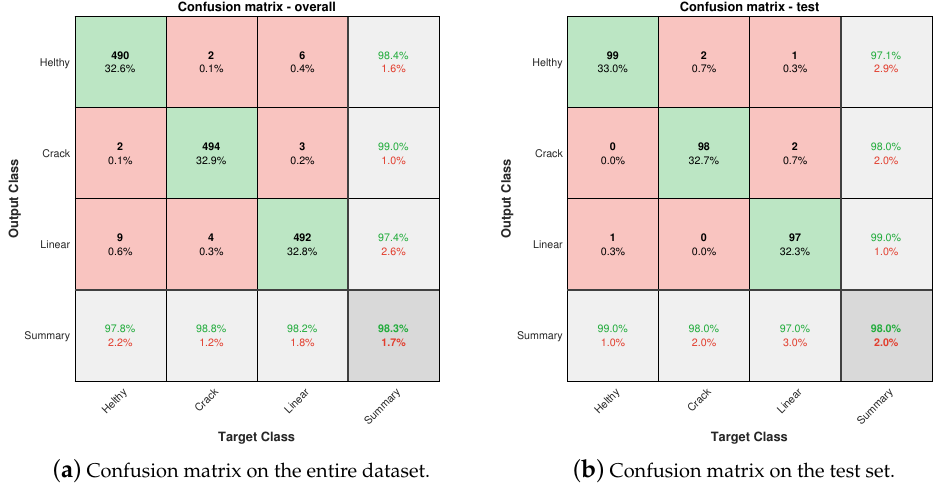
Figure 14. Confusion matrices for the entire dataset and the training